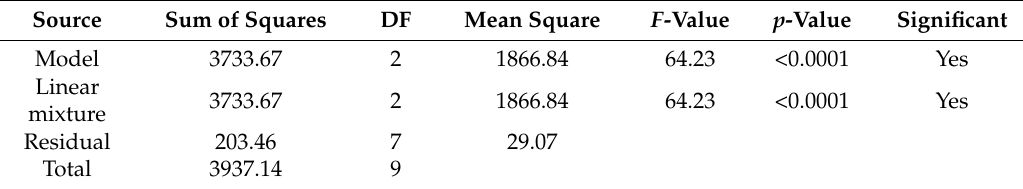
Table 6. ANOVA results for modulus of immediate elasticity Burgers model ( E 1